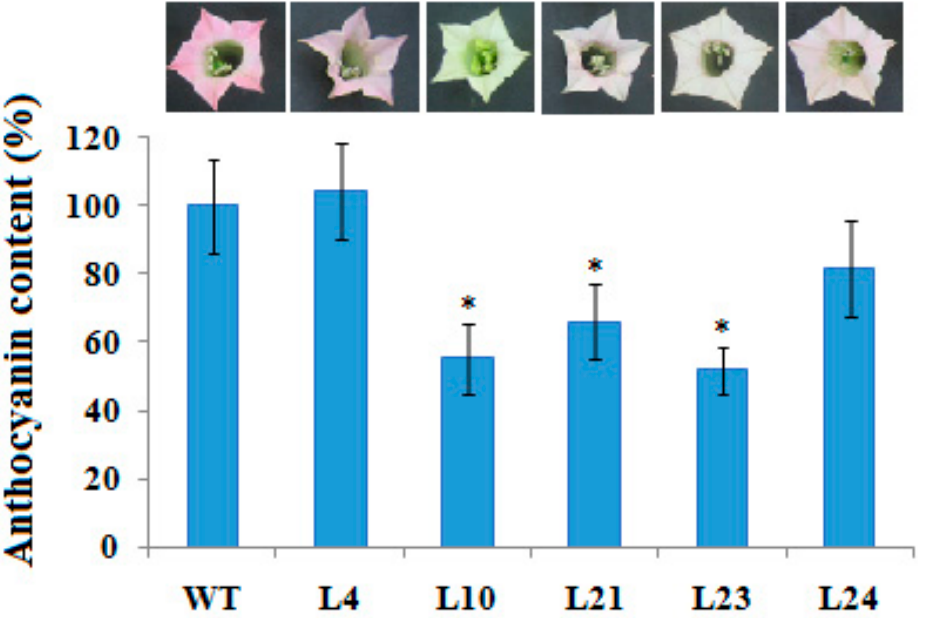
Figure 7. Decrease in the anthocyanin content in flower petals of transgenic tobacco plant lines transformed with the VlvSTS gene (%).The content of anthocyanins in control plants is taken as 100%. WT—non-transformed plant. L4, L10, L21, L23, L24—lines of transgenic plants. * Statistically significant at Mann-Whitney test ( p < 0.05). Table 1. Quantitative characteristics of pollen grains in tobacco plants with VlvSTS gene. Plant Lines